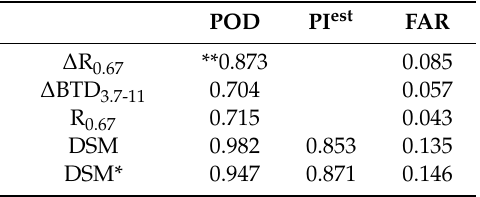
Table 5. POD values ( ∆ R 0.67 , ∆ BTD 3.7-11 , and R 0.67 ), and the PI est values of DSM and DSM* for the LSF detection validation during Period 2 (2014-2015) using the thresholds of the satellite-observed variables for Period 1 (2012–2013). The FAR values of the five methods are also given. **The ∆ R 0.67 values within ± 2% have been used as the upper limit condition of PI est . The POD values of DSM and DSM* have been obtained from the NFL data, not from WF ( Class i )